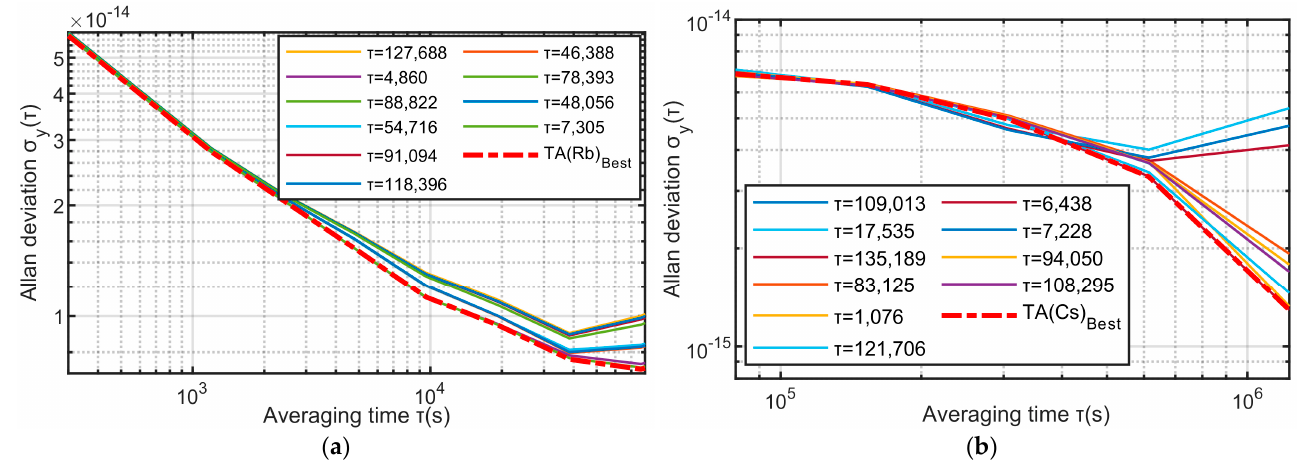
τ . Figure 8. The frequency stability of the time scale of the fitness-optimal τ